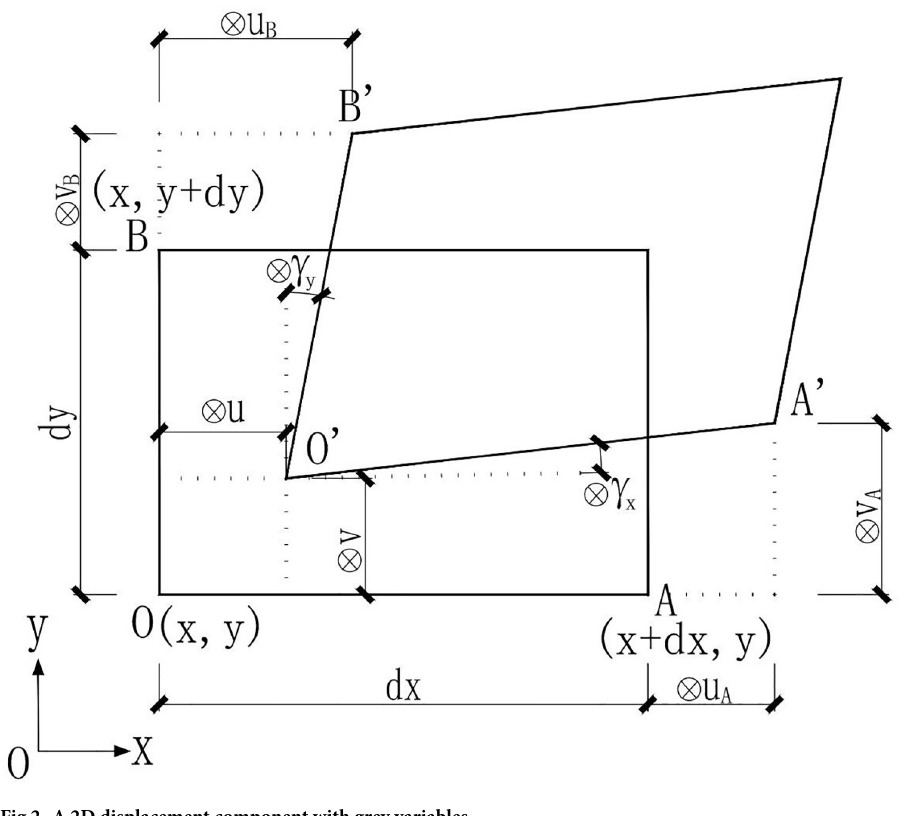
Fig 2. A 2D displacement component with grey